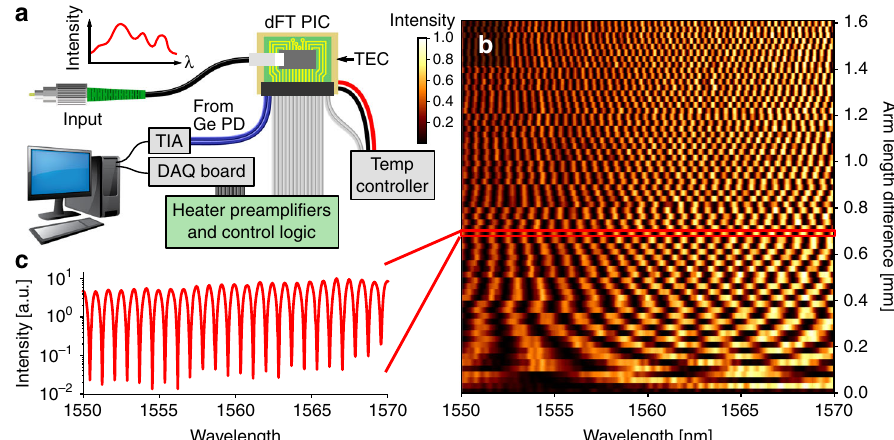
Fig. 2 Packaged dFT photonic integrated circuit (PIC) and spectral basis set. a Schematic diagram of the dFT spectrometer characterization setup; b an exemplary transmission spectrum of the dFT device corresponding to an arm length difference of 0.7 mm; c transmission spectra of the device for all 64 permutations of the switch on/off combinations: the ensemble of 64 spectra constitute the basis set for spectrum